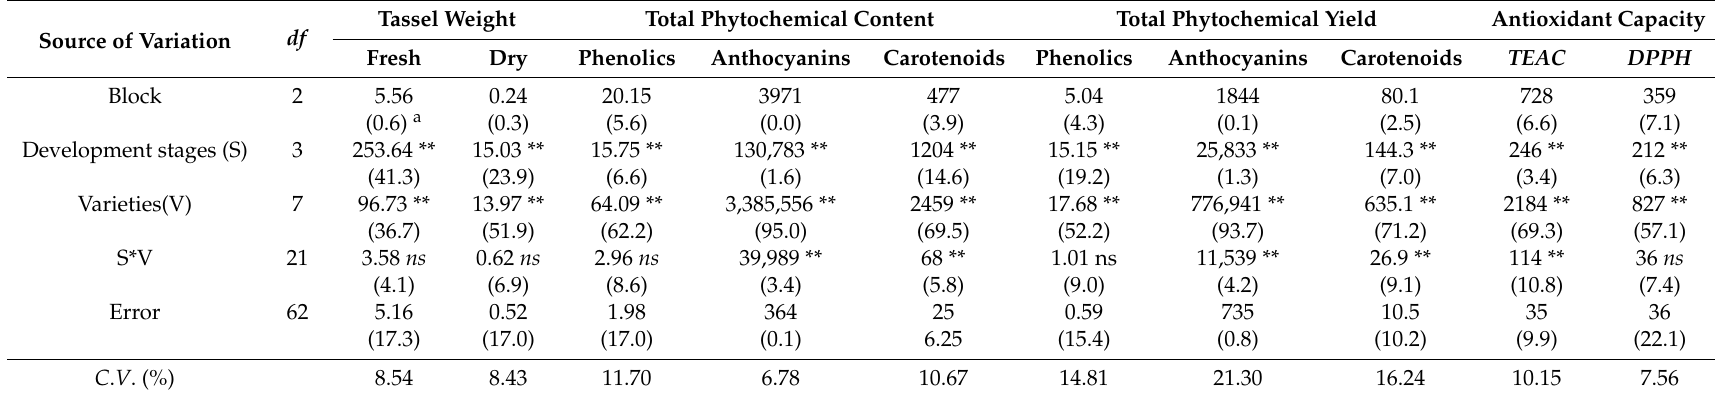
Table 2. Mean squares for the tassel weights, phytochemical contents, and antioxidant capacity of eight corn hybrid varieties evaluated at four corn tassel development